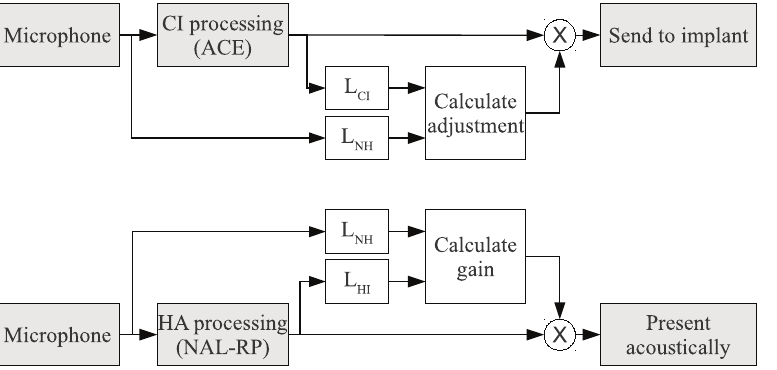
Figure 1. Block diagram of ACE and SCORE processing. The grey blocks indicate the clinical ACE processing and the white blocks the add-on SCORE processing. L NH , L HI , and L CI indicate respectively loudness models for normal hearing, impaired hearing and cochlear implant (electrical) stimulation.